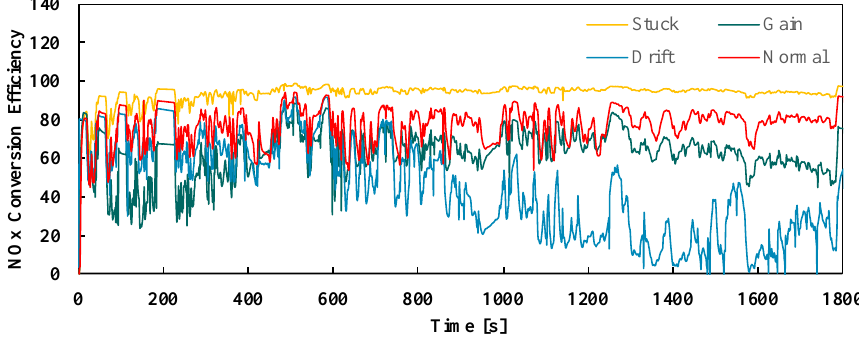
Figure 8. Outlet NO x concentration vs. time.